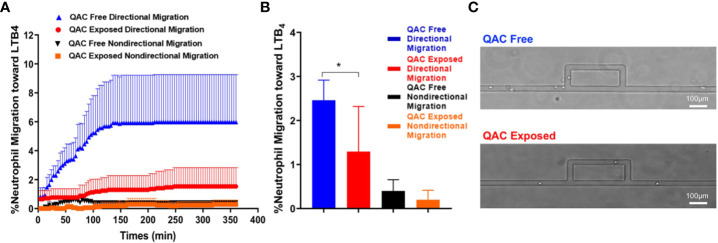
Decreased ex-vivo migration and chemotaxis of neutrophils with ambient exposure to QACs. (A) Pattern of the competitive chemotaxis toward LTB4 as determined by a microfluidic μC3 assay. (B) Percentage of migrated neutrophils toward LTB4. (C) Representative micrographs showing directional (straight channels) vs. non-directional migration (cells were lost within the maze). Data obtained from 12-week-old mice are shown as mean ± SEM. n = 5/group, *P < 0.05.